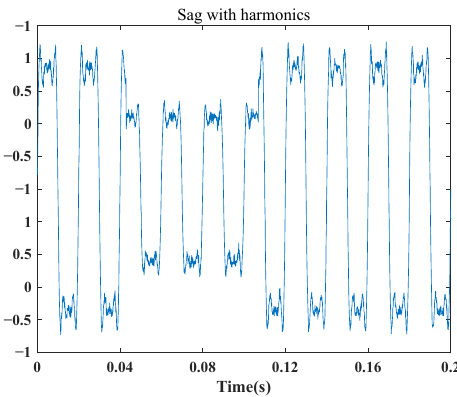
Figure 5. Original sag with harmonics signal.